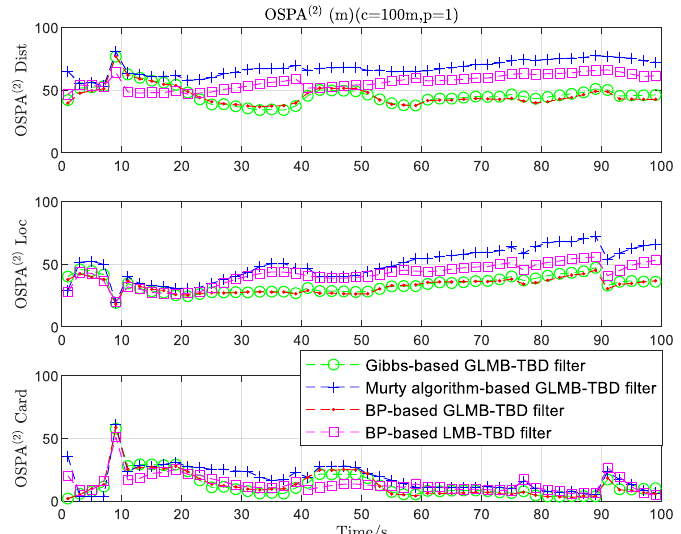
Figure 6. The error curves for the final estimations from the different methods over 100 Monte Carlo runs.